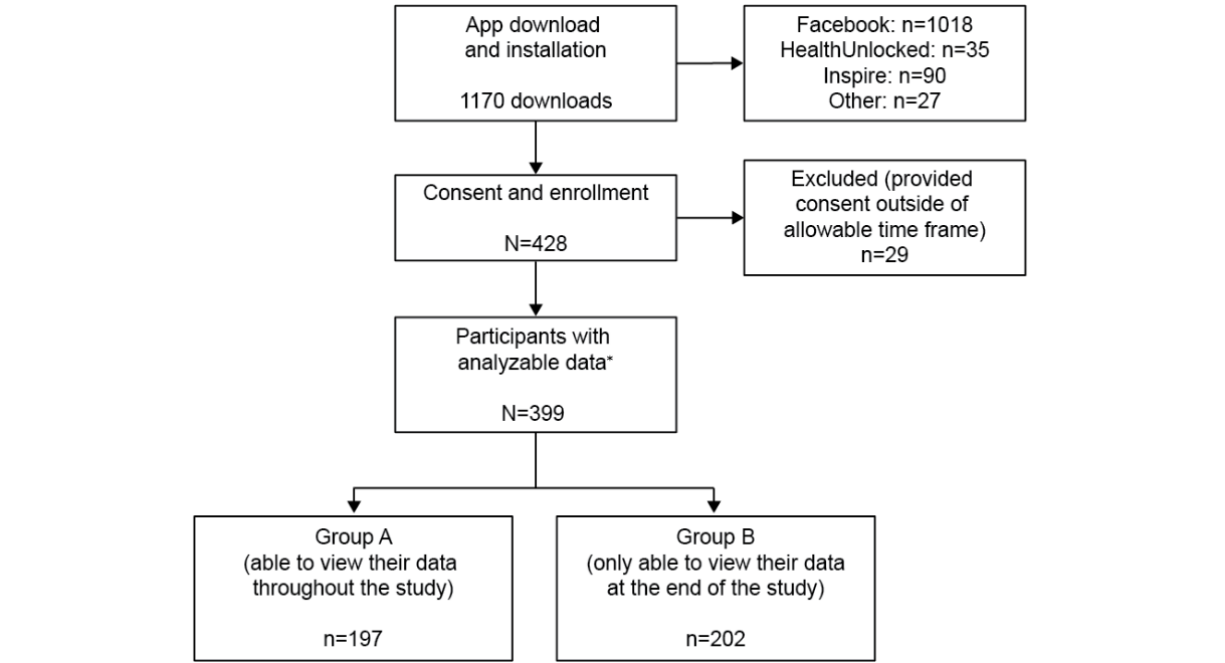
Figure 2. Patient Rheumatoid Arthritis Data From the Real World (PARADE) app study recruitment. *Defined as those completing all demographic